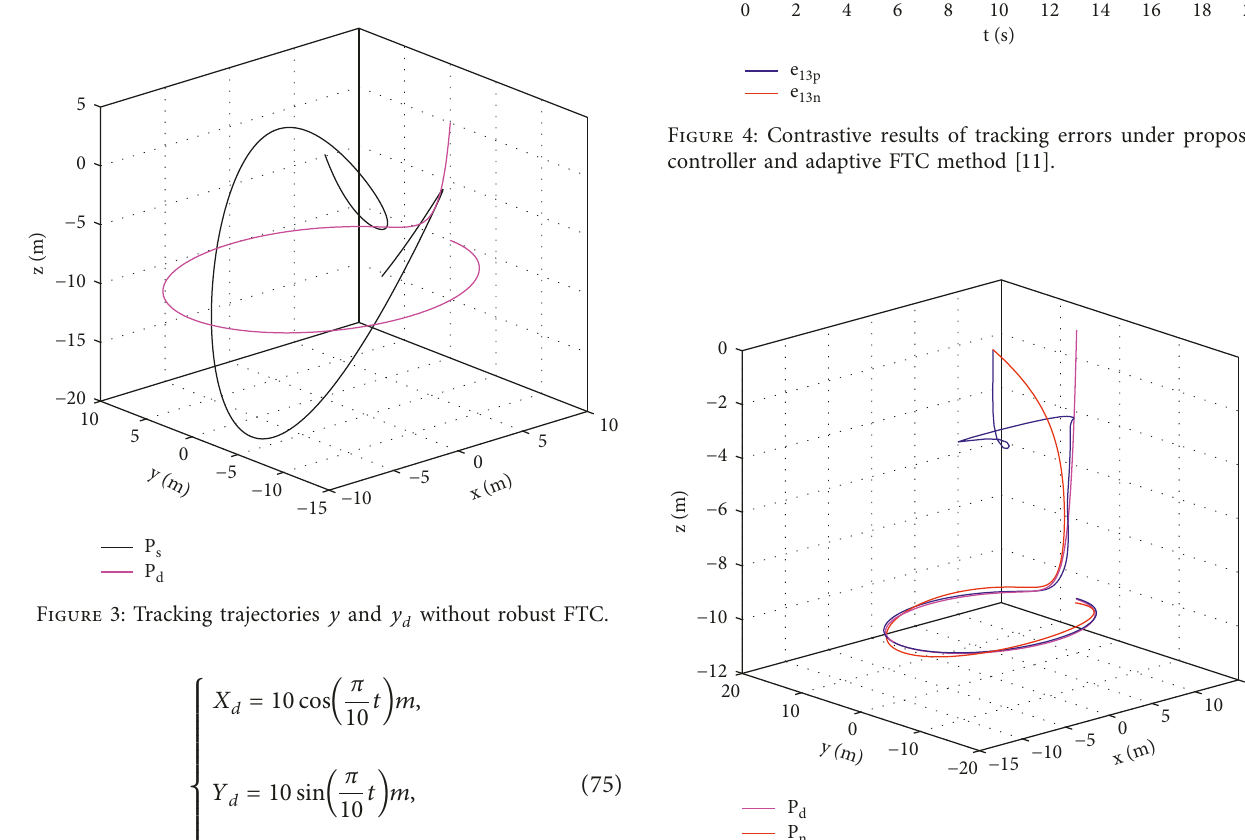
Figure 2: Tracking errors e